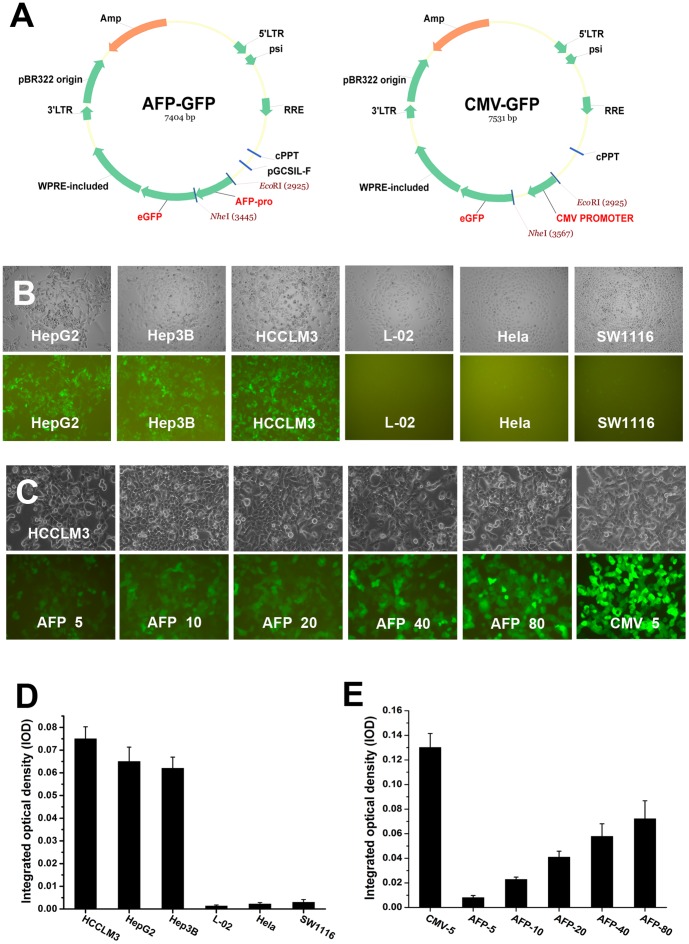
Activity and tissue-specificity of the AFP promoter.(A) Construction of recombinant lentiviral vectors containing GFP reporter gene driven by AFP promoter or CMV promoter (AFP-GFP and CMV-GFP) for AFP promoter assay. (B,D) The AFP promoter is active and HCC tissue-specific. GFP was highly expressed in AFP-producing HCC cells (HepG2, Hep3B, and HCCLM3) but not in non-HCC cells (normal hepacyte L-02, cervical cancer cell Hela, and colon cancer cell SW1116). (C,E) The AFP promoter was efficient for transgenic expression but its activity was weaker than CMV-promoter, as exemplified by HCCLM3 cells infected with AFP-GFP (MOI = 5–80) and CMV-GFP (MOI = 5).